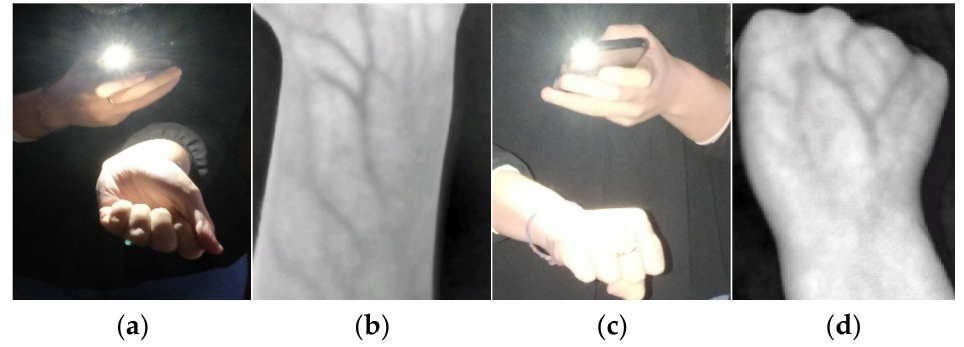
Figure 1. Examples of acquisition with the IRVeinViewer app: ( a , c ) acquisition procedure; ( b , d ) final images